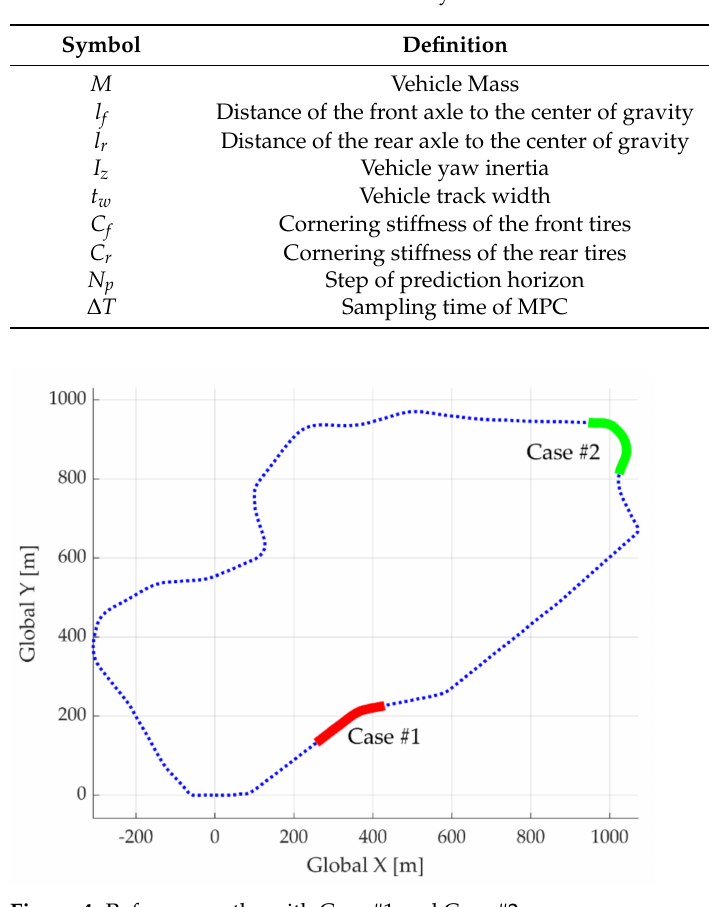
Figure 4. Reference paths with Case #1 and Case #2.